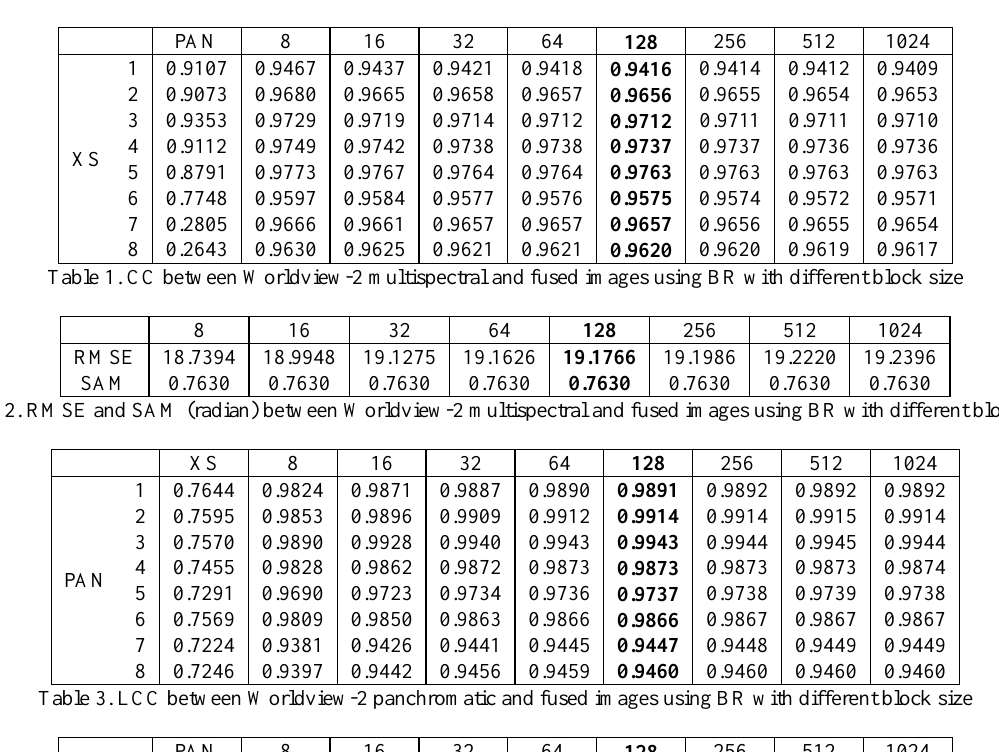
Figure 2. Pan-sharpened QuickBird images using BR with different block size (color composites of 4, 3, and 2 bands, false infrared (IR) color for display, display scale 1:1, the result of 1024 × 1024 is not shown because of page limit)